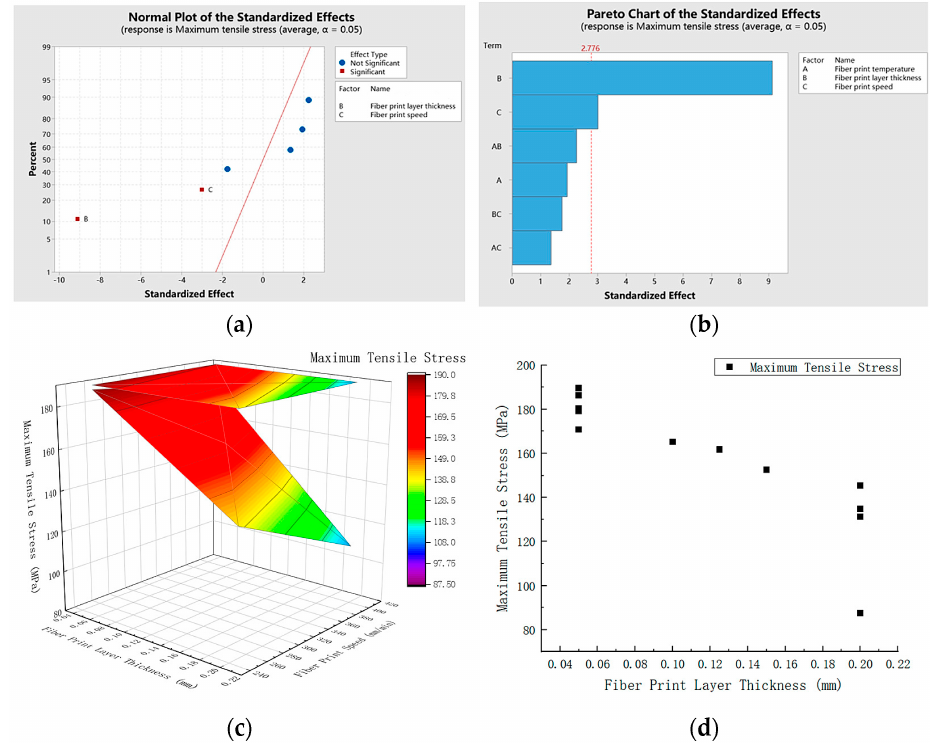
Figure 5. Analysis diagram of the results of the full factor test: ( a ) Normal diagram; ( b ) Pareto diagram; ( c ) graph of printing layer thickness, printing speed, maximum tensile stress; ( d ) scatter plots between layer thickness and maximum tensile stress.